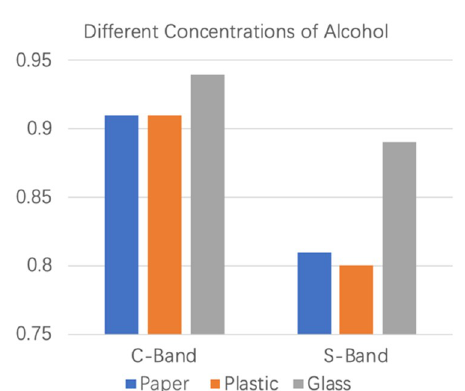
Figure 11. Detection results of different concentrations of alcohol at the C-band and the S-band.